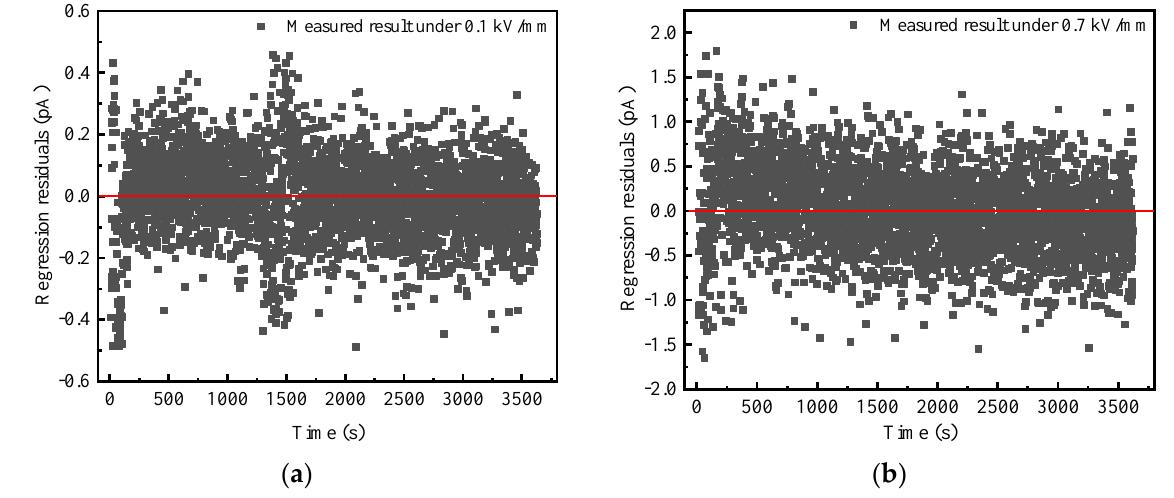
Figure 5. Residual values of BN powder at 25 °C. ( a ) 0.1 kV/mm; ( b ) 0.7 kV/mm.